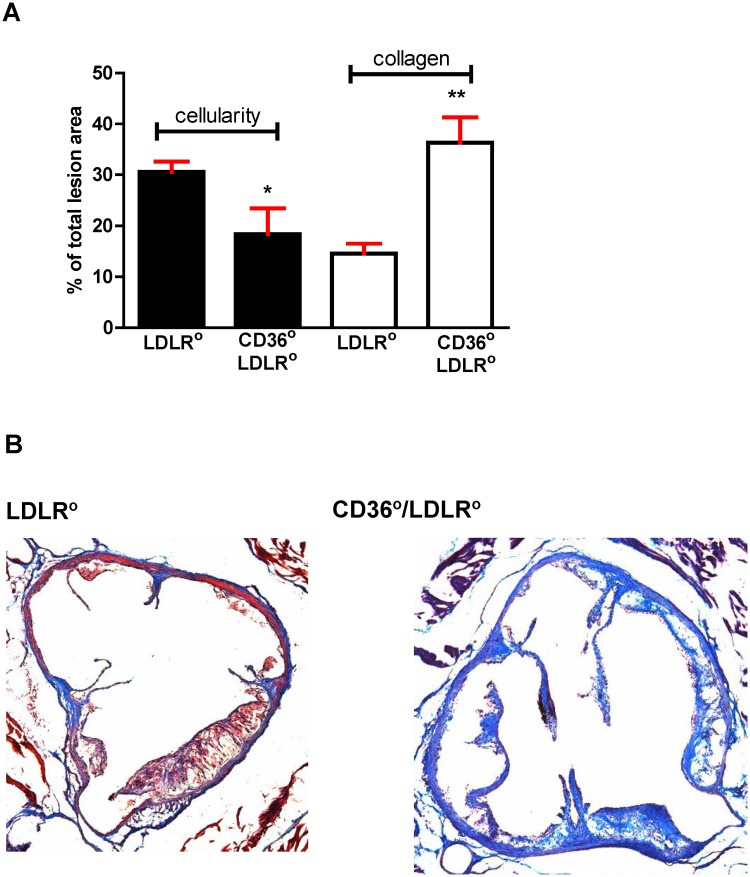
Morphological assessment of aortic sinus lesions in Pg infected mice.
A. Lesions from Pg infected Ldlr° mice had greater cellularity and reduced collagen content compared with those from Cd36°/Ldlr° mice (n = 13 lesions/group from 5–6 mice). Student’s two-tailed t-test, *p<0.05, **p<0.0005. B. Representative lesions stained with trichrome. Red = cells; Blue = collagen.